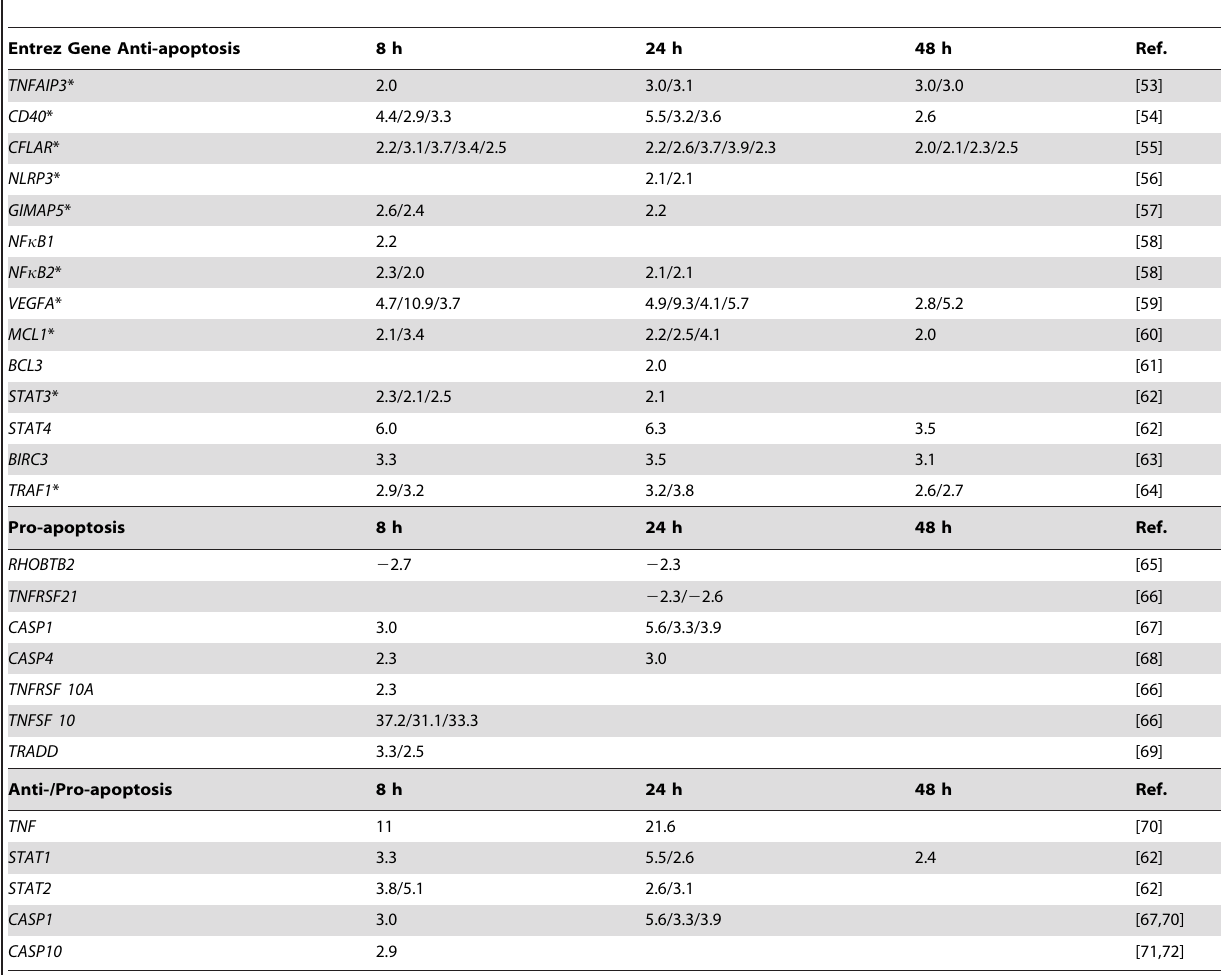
Table 3. Selected genes involved in apoptotic cell death with altered expression observed in hMDMs 8, 24 and 48 h after S. aureus